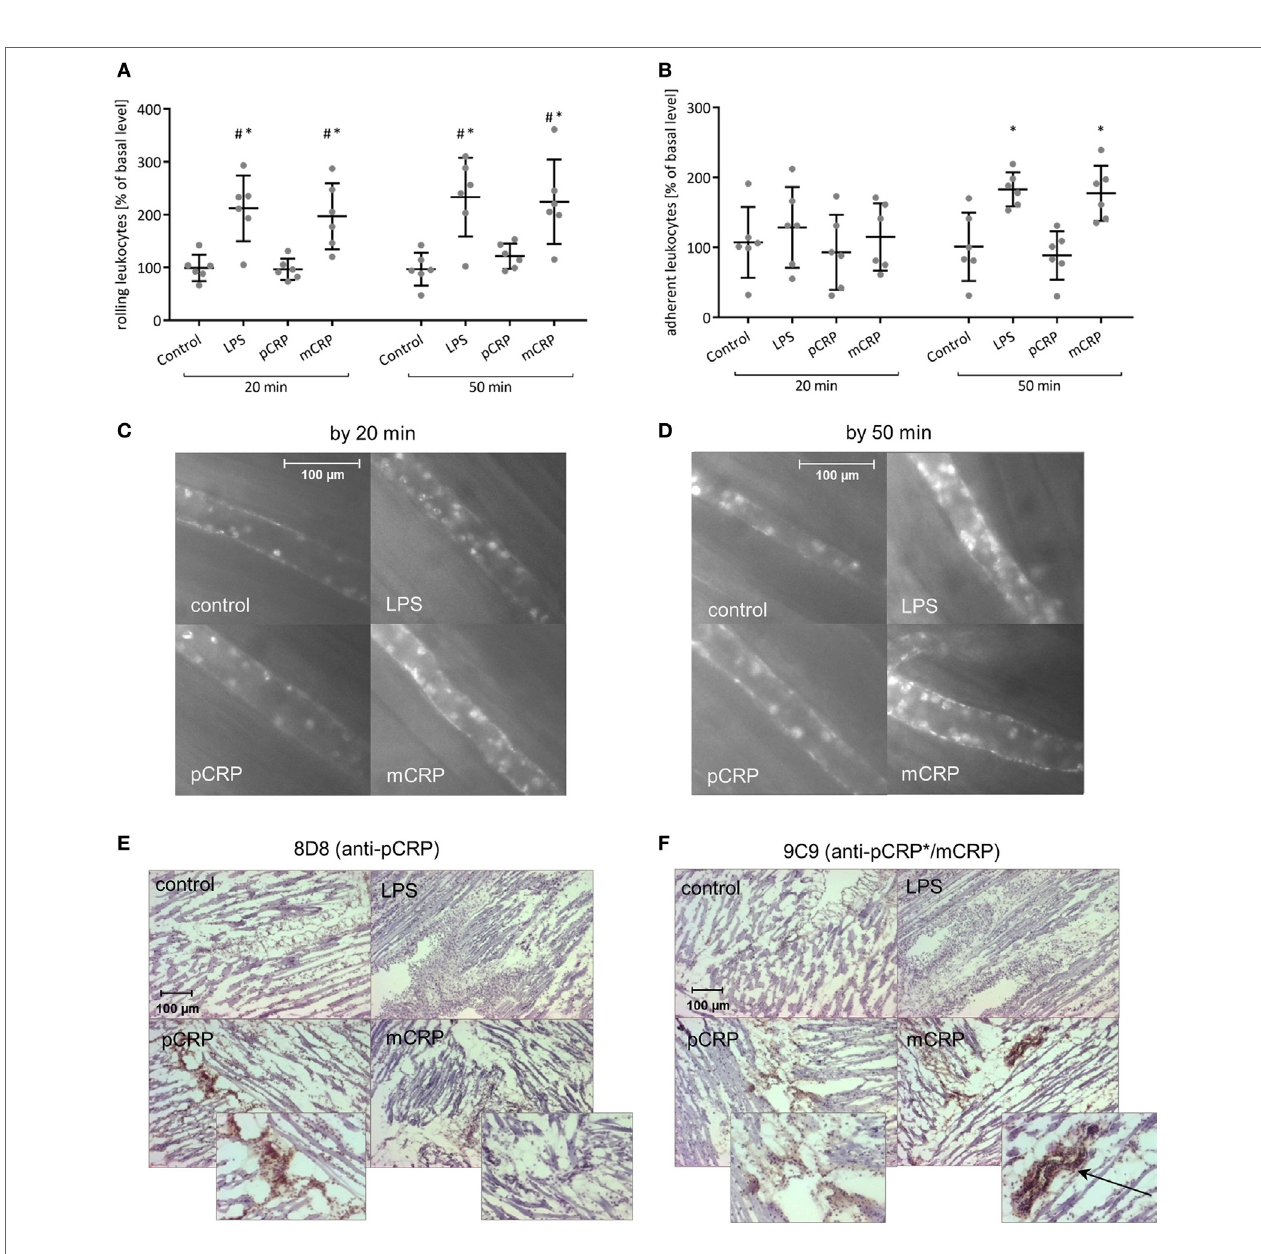
FigUre 2 | C-reactive protein (CRP)-induced aggravation of ischemia/reperfusion injury (IRI) is controlled by a localized conformational change regulating leukocyte recruitment. (a,B) Intravital microscopy of rat cremasteric postcapillary venules to determine leukocyte–endothelial interaction in IRI ± i.v. injection of pentameric C-reactive protein (pCRP) (25 µg/ml). Leukocytes were labeled with Rhodamine 6G. Counts at 0 min was set to 100%. Values are mean ± SEM of 10–14 observed venules in 6 rats. # p < 0.05. i.v. application of pCRP aggravates IRI and significantly increases leukocyte rolling (a) and adhesion (B) . 1,6-bisPC masks the pro-inflammatory potential of CRP in IRI and induces a significant decrease in leukocyte rolling (a) and adhesion (B) compared to the IRI + pCRP group. 1,6-bisPC alone has neither pro- nor anti-inflammatory potential. (c,D) Immunohistochemical staining of the cremaster muscle with DAB after IRI ± i.v. application of pCRP. Clone 8D8 (c) was used to detect pCRP and clone 9C9 (D) was used to detect conformationally altered CRP. Representative results are shown ( n = 6 for each sample). After i.v. application, pCRP can be detected in the cremasteric tissue (arrow). Staining gets less pronounced in IRI. Neo-epitope expressing CRP is strongly detectable after pCRP injection in IRI (arrow), though trace amounts are detected in healthy tissue. IRI induces an alteration of the CRP conformation and a deposition in the inflamed tissue. (e) Immunohistochemical staining of the cremaster muscle with DAB after IRI and i.v. application of pCRP ± 1,6-bisPC. Stabilization of pCRP by 1,6-bisPC abrogates the formation and deposition of conformationally altered CRP. (F) Western blot analysis of native PAGE (1/20 SDS) of I/R-injured rat cremaster muscle tissue stained for mCRP with antibody clone 9C9 and 8D8. In the I/R-injured muscle tissue, altered CRP accumulates after the dissociation of pCRP. 1,6-bisPC stabilizes pCRP in its native conformation and, therefore, altered CRP is not detectable in 1,6-bisPC-treated rats. (g) Flow chart of the intravital experimental